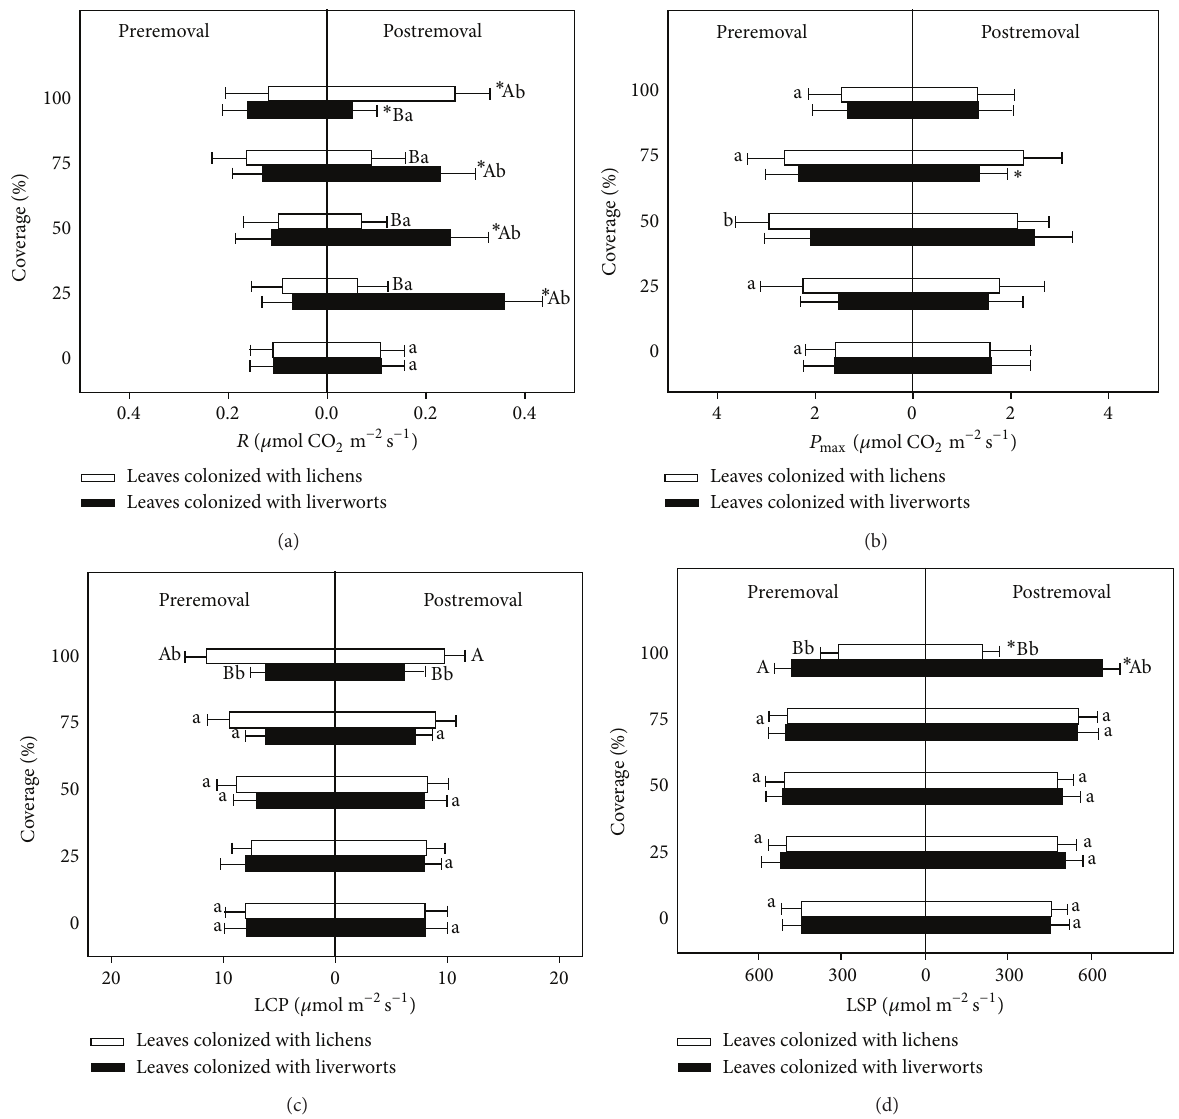
Figure 3: Estimated photosynthetic parameters of Photinia prunifolia colonized with lichens and liverworts, pre- versus postremoval (mean ± 1SE)( 𝑛 = 4 ).(a)Respirationrate( 𝑅 ),(b)maximumratesofphotosynthesis( 𝑃 max ),(c)lightcompensationpoint(LCP),and(d)lightsaturation point (LSP). The symbol ∗ indicates the difference of photosynthetic parameters between pre- and postremoval treatment; different small and capital letters near the bars indicate the differences among leaves with different coverage and between leaves colonized with liverworts and lichens ( 𝑃 < 0.05